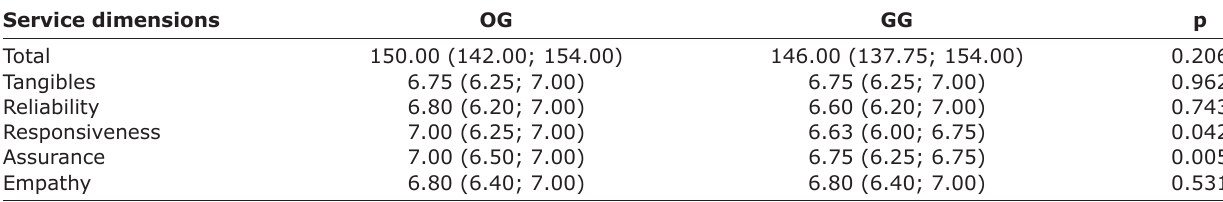
Table-2: Summarized information concerning the results obtained for client perceptions. Service